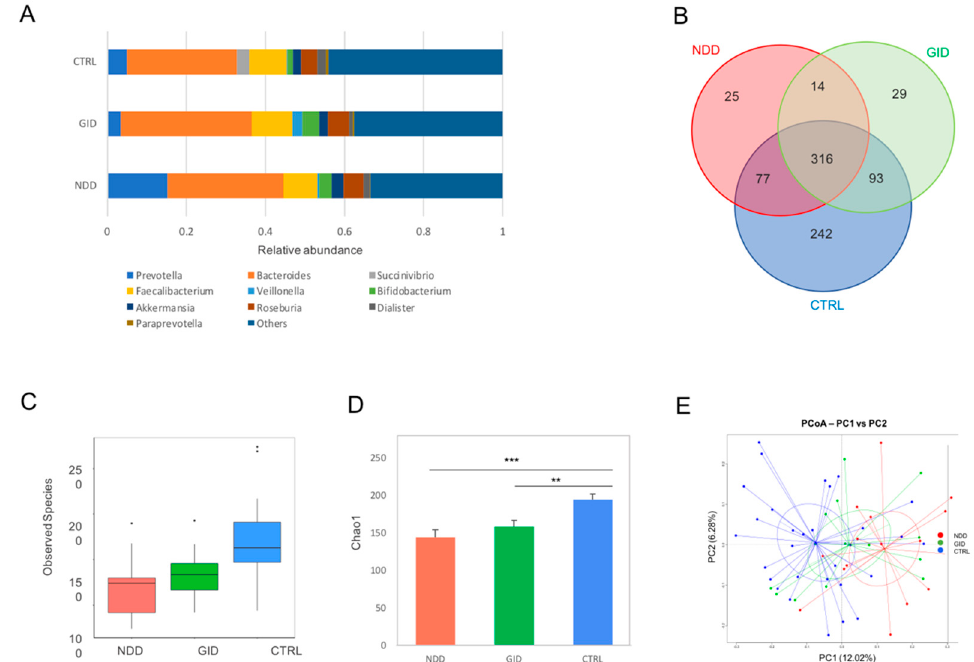
Figure 1. Overview of bacterial diversity in NDD, GID and control (CTRL). Relative abundances of the 11 most significant bacterial genera ( A ); Venn diagram summarizing number of operational taxonomic units (OTUs) shared between different groups ( B ); alpha diversity indices including the number of observed species ( C ) and the Chao1 index ( D ); beta-diversity indicated by PCoA plot of unweighted UniFrac distance by groups ( E ). Significant difference of the NDD group compared to CTRL and GID group compared to CTRL was noted by * p < 0.05; ** p < 0.05; and *** p < 0.005.